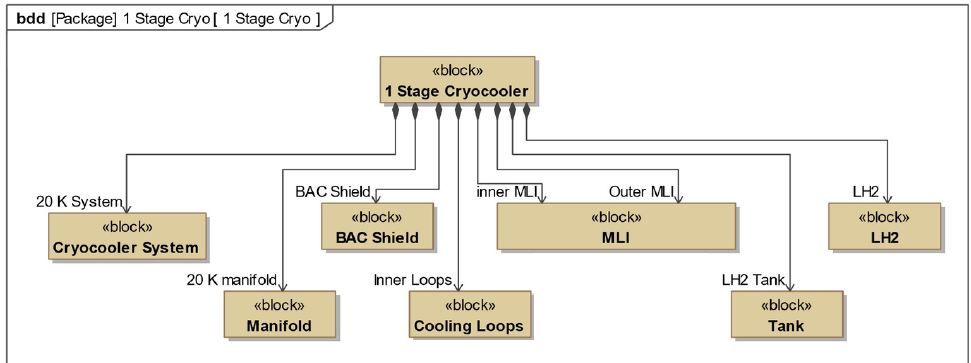
Figure 11. Single cooling circuit thermal management system BDD.